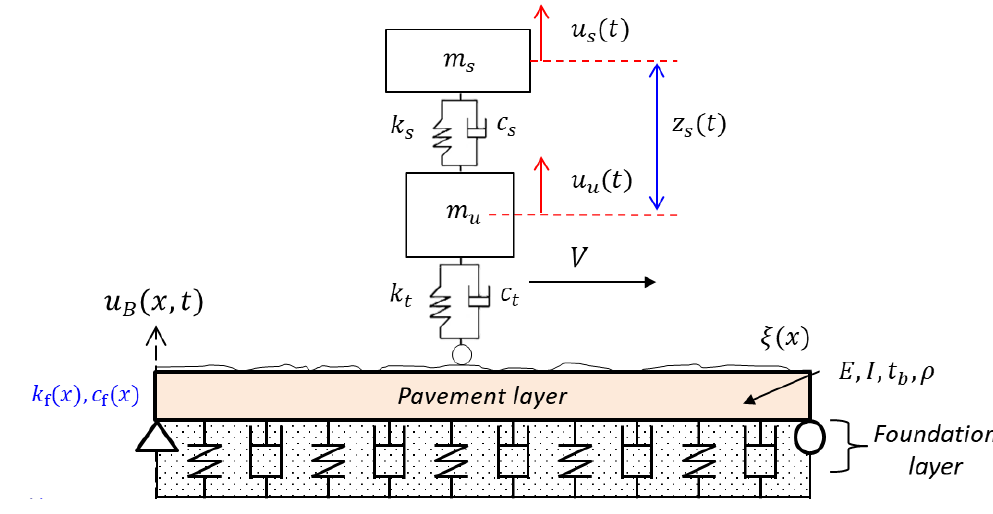
Figure 1. Vehicle–pavement–foundation system.